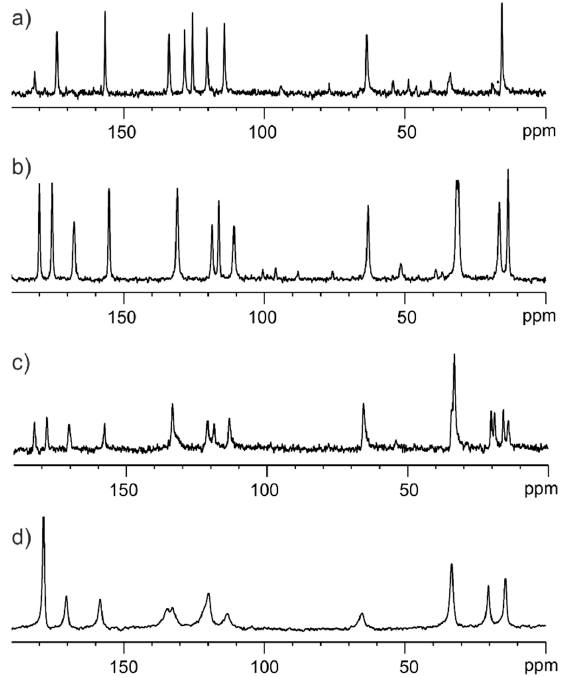
Figure 8. ( a ) 13 C CP/MAS spectrum of physical mixture of ET and GLU, ( b ) 13 C CP/MAS spectrum of well-defined ET:GLU cocrystal, ( c ) 13 C CP/MAS spectrum of the physical mixture ET:GLU cocrystal and SiO 2(hydr) with a weight-to-weight ratio of 1:3, ( d ) 13 C SPE/MAS spectrum of the ET:GLU/SiO 2(hydr) physical mixture (1:3) recorded with a spinning rate of 12 kHz. Figure 9 shows the PXRD, DSC, and VT NMR data for the physical mixture of the ET:GLU cocrystal and SiO 2(hydr) . Diffractograms shown in Figure 9a reveal that the freshly mixed sample contains the crystalline ET:GLU components and amorphous phase; however, after melting and cooling, the sample is amorphous, as shown by DSC studies. (Figure 9b). The first run (blue line) shows the melting of the cocrystal at 69 ◦ C. During the cooling (green line), the recrystallization of ET:GLU is not observed. The full amorphization is confirmed by the second run (red line). 1 H MAS (Figure 9c, left column) and 13 C SPE MAS (Figure 9c, right column) provide further evidence showing that, when increasing the temperature from 30 ◦ C to 80 ◦ C, the cocrystal is in a molten state.